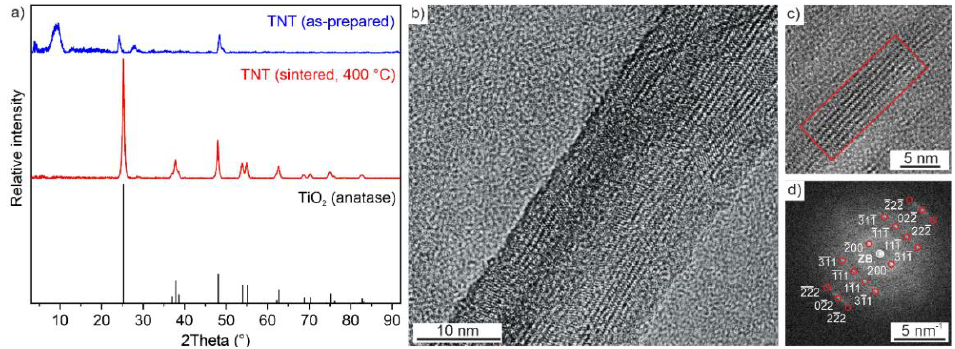
Figure 3. Crystallinity of the TNTs: ( a ) X-ray powder diffraction of the as-prepared TNTs, TNTs sintered at 400 °C (TiO 2 /anatase as a reference: ICDD-No. 086-1157), ( b ) HRTEM of sintered TNTs (400 °C), (c + d) HRTEM of sintered TNTs (400 °C) with FFT analysis in ( d ) of the crystalline area marked with red frame in ( c ) (ZB: zero beam).